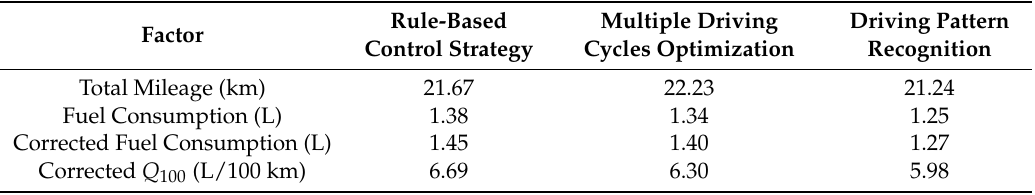
Table 13. Road test comparison